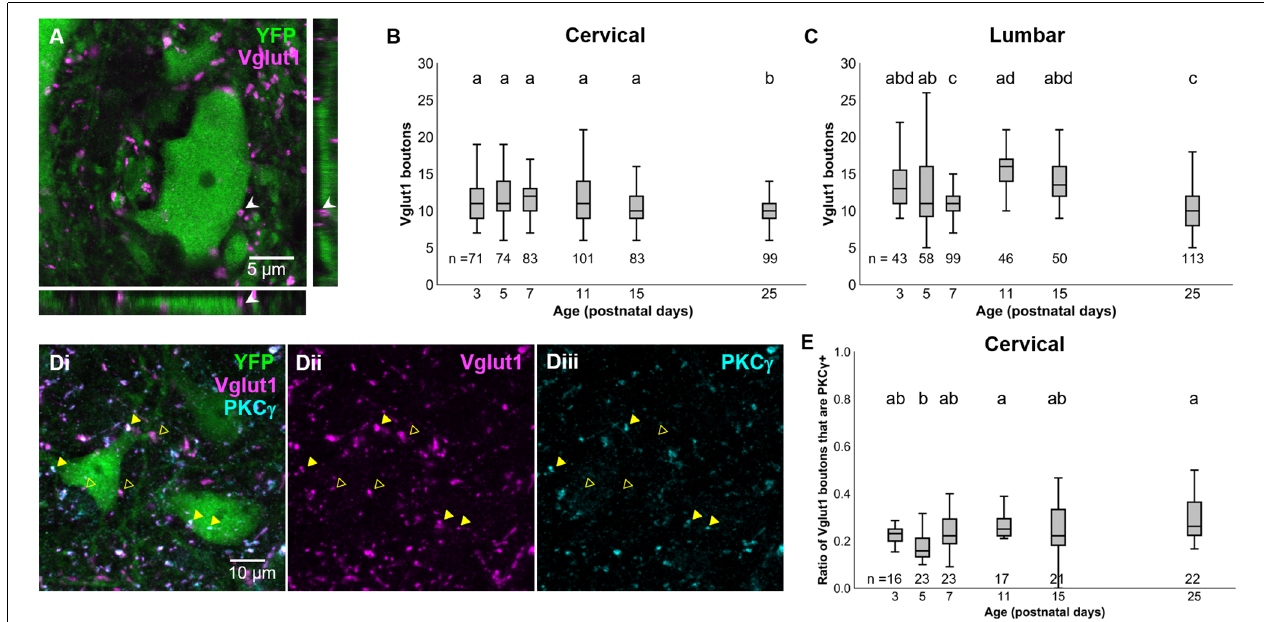
FIGURE 2 | Development of Vglut1+ inputs on dI3 INs. (A) Vglut1+ terminals on lumbar YFP+ dI3 IN from a P3 spinal cord. (B) Vglut1+ boutons on cervical dI3 INs and (C) lumbar dI3 INs at time points between P3 and P25. (D) PKC γ +/VGLUT1+ (filled triangles) and PKC γ -/VGLUT1+ (clear triangles) boutons on cervical dI3 IN from a P25 spinal cord. (E) Time course of development of the ratio of PKC+/VGLUT1+ boutons on cervical dI3 INs. One-factor ANOVA. Pairs of groups sharing a letter are not statistically different at the p < 0.05 level according to Tukey’s post-hoc Test. For example, the means of two groups with the letter “a” are not pairwise statistically different.